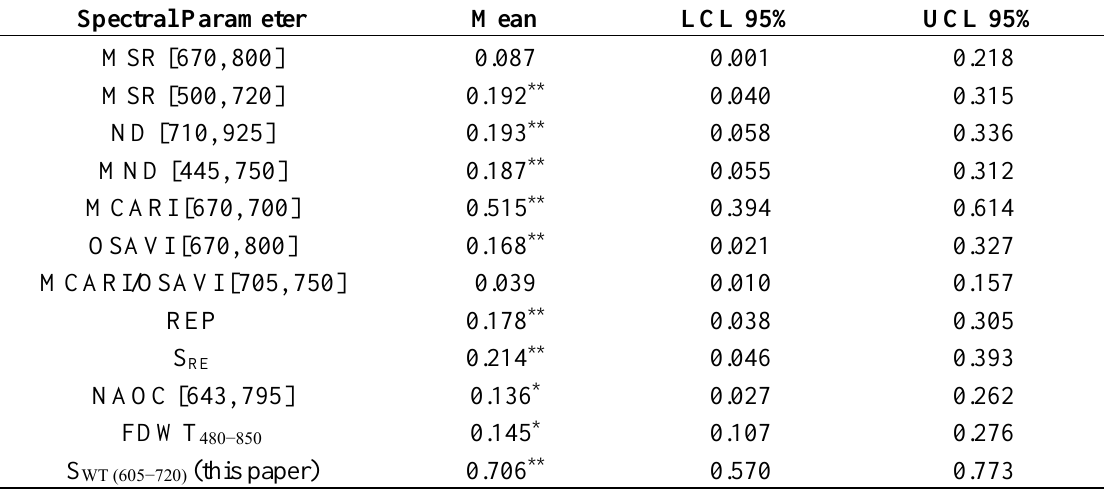
4. Bootstrapped determination coefficient (R 2 ) for quantifying foliar Cu concentration with the 10 classical chlorophyll-related spectral parameters listed in Table 1 and one published wavelet-based area parameter using the full dataset ( N =